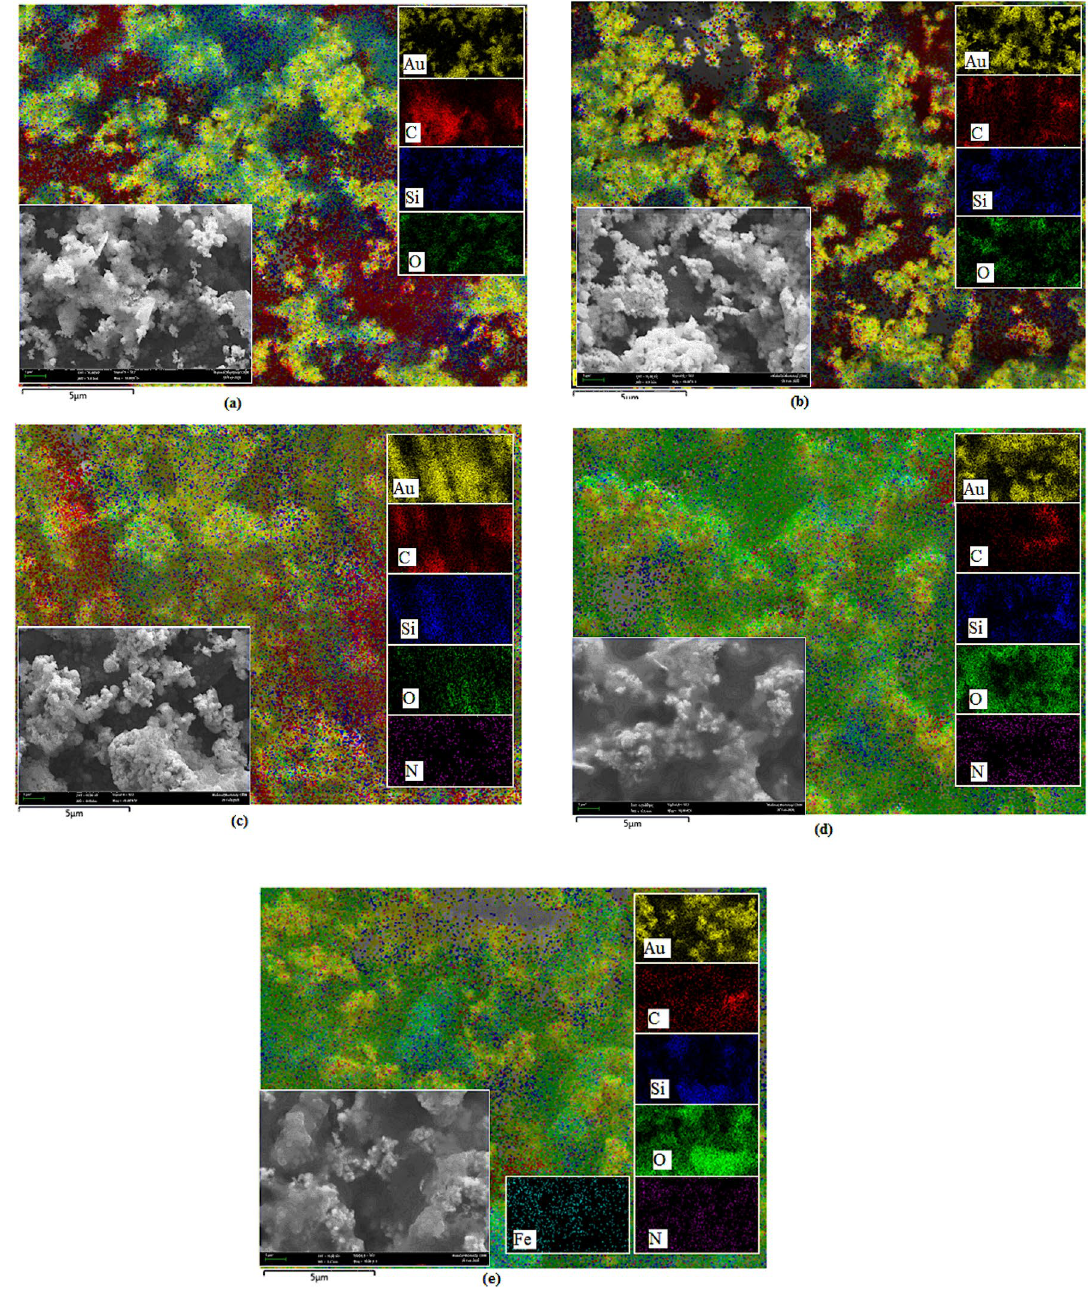
Figure 7. EDX elemental mapping analysis. Inset: FESEM micrograph of DNA biosensor; ( a ) silica nanospheres (SiNSs) with gold nanoparticles (AuNPs); ( b ) SiNSs, AuNPs, glutaraldehyde; ( c ) after immobilization with DNA probe; ( d ) after hybridisation with complementary DNA; ( e ) after intercalation with